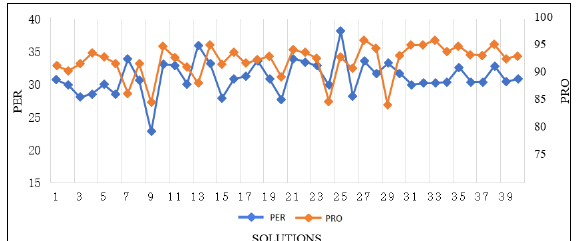
Figure 3. The objectives of the scheduling results